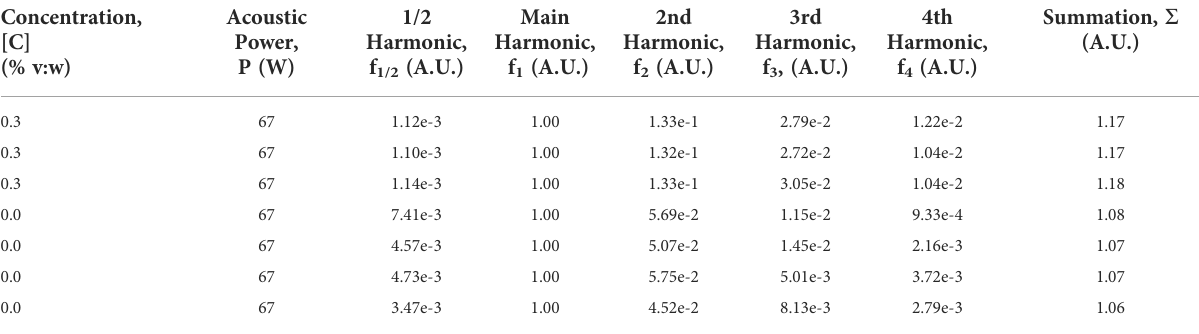
Summation, S (A.U.) f 4 (A.U.)